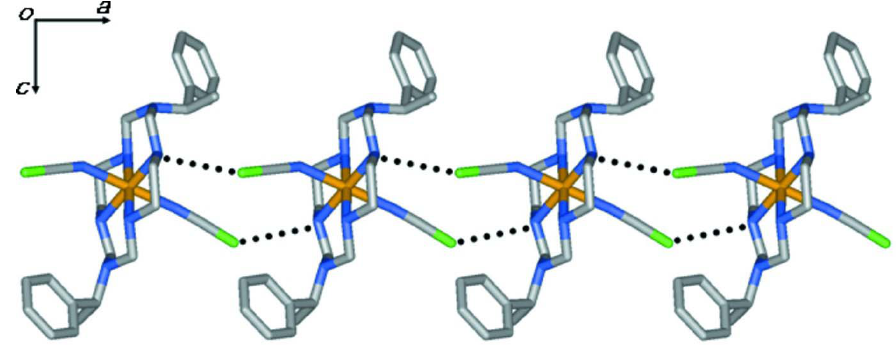
Perspective view of the title compound showing a one-dimensional chain formed by N—H···S hydrogen bonding